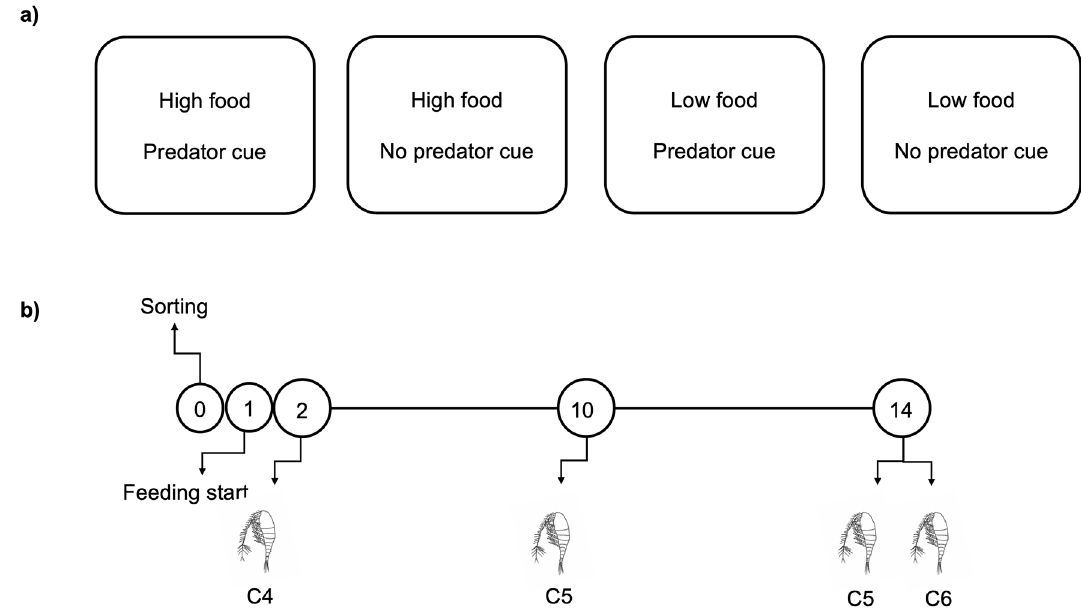
Figure 1. Treatment combinations and timeline of the experiment. ( a ) High food ( Rhodomonas baltica ): 200 μg C/L. Low food: 90 μg C/L. The tanks with predator cue continuously received water from a tank of lumpfish ( Cyclopterus lumpus ) juveniles fed Calanus finmarchicus . No predator cue: filtered sea water. Each treatment had three replicate tanks, each of which were sampled on each sampling day. ( b ) Sampling of copepods for